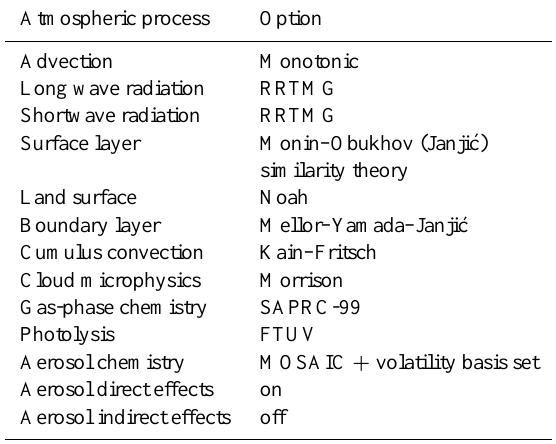
Table 3. Selected WRF-Chem configuration options used for this